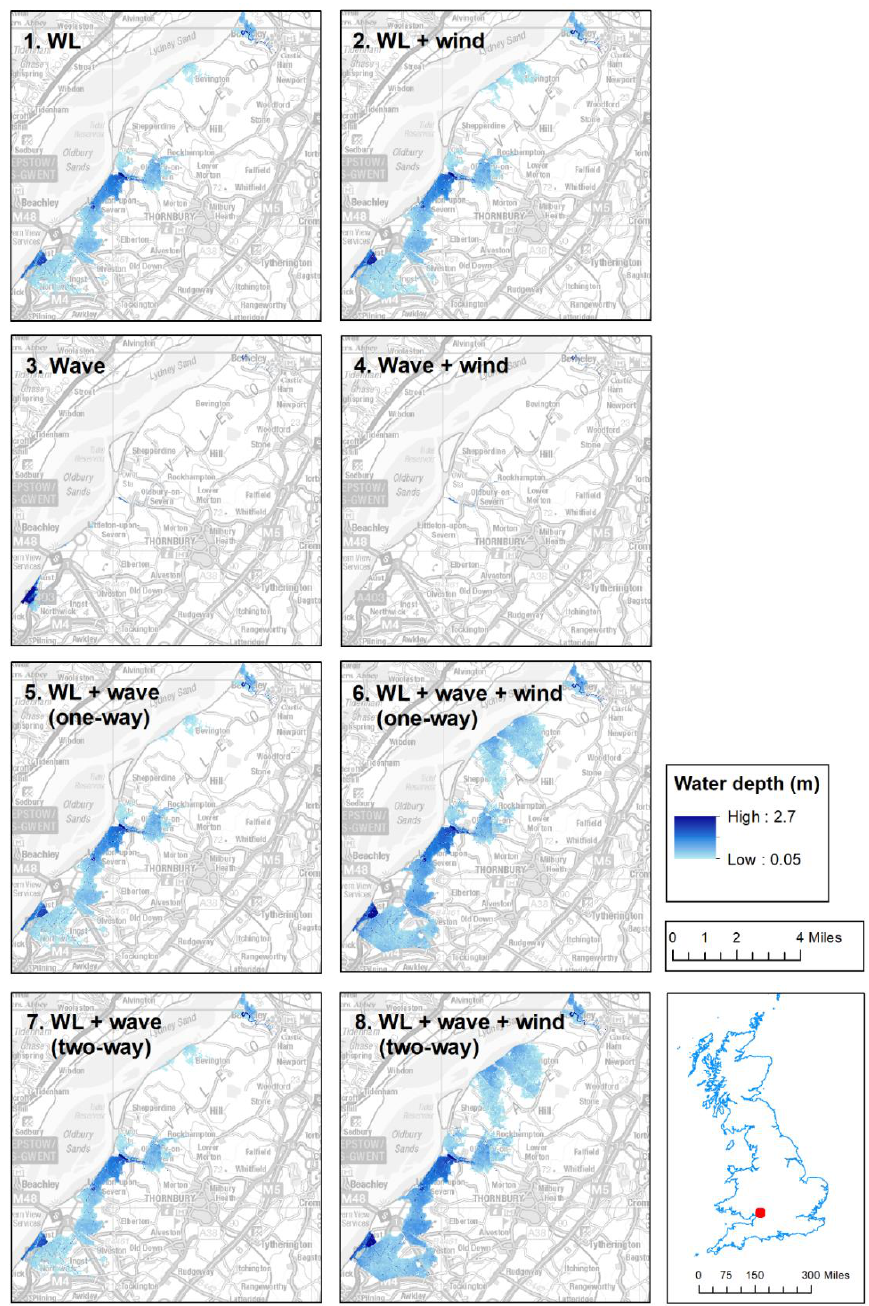
Figure 4. Depth and extent of flooding at Oldbury-on-Severn for HP approach to forcing the model boundary where maps 1 – 8 represent coastal hazard uncertainty (see Table 1) for January